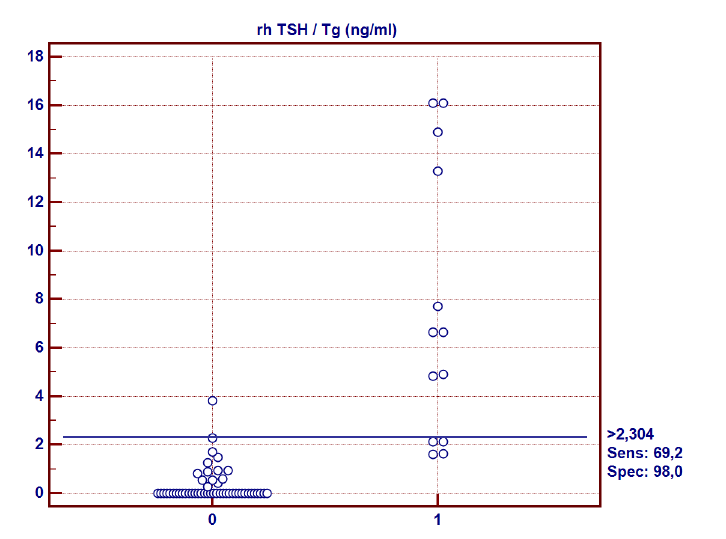
doi:10.1371/journal.pone.0133852.g003